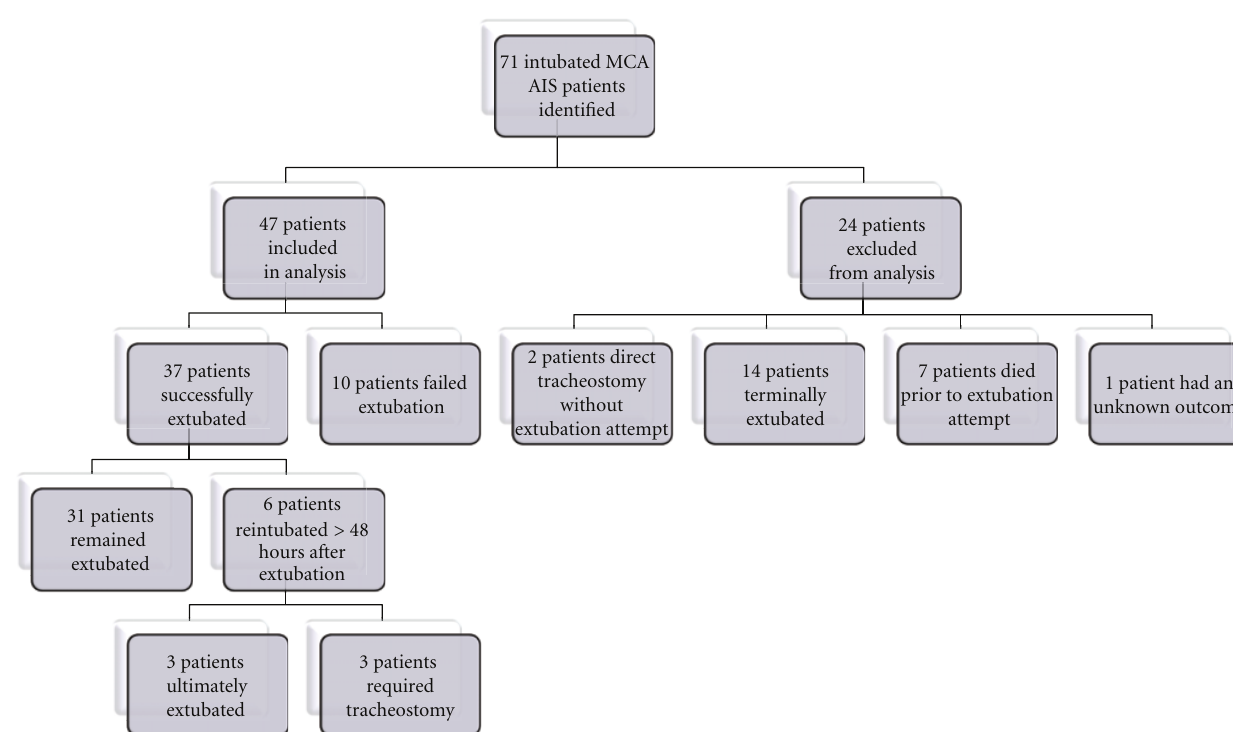
Figure 1: Extubation outcomes of intubated middle cerebral artery (MCA) acute ischemic stroke (AIS) patients identified.